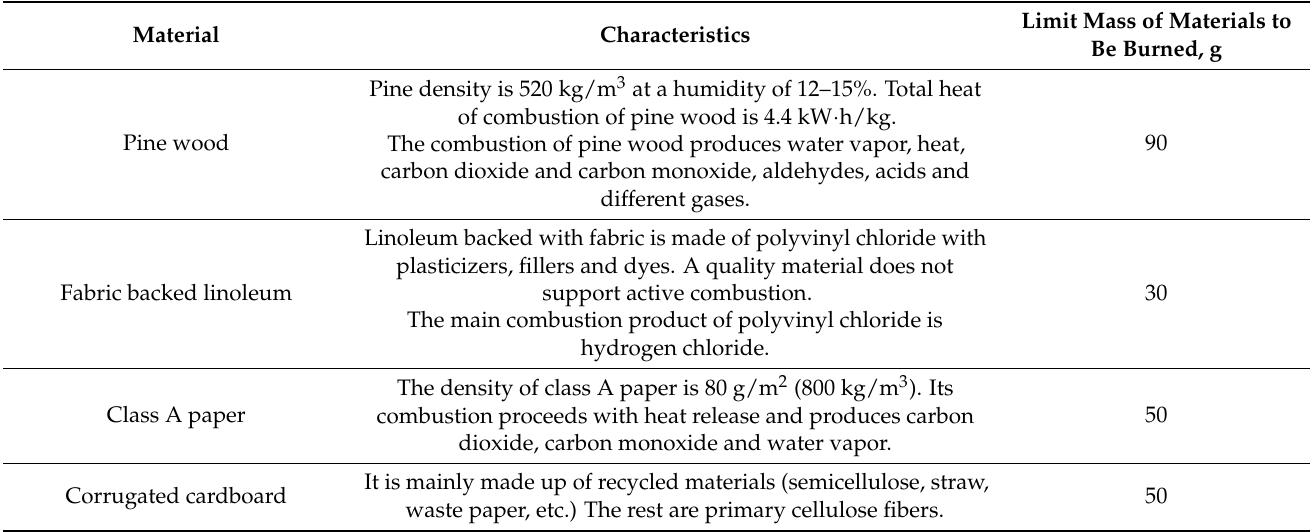
Table 2. Characteristics of combustible materials used in the